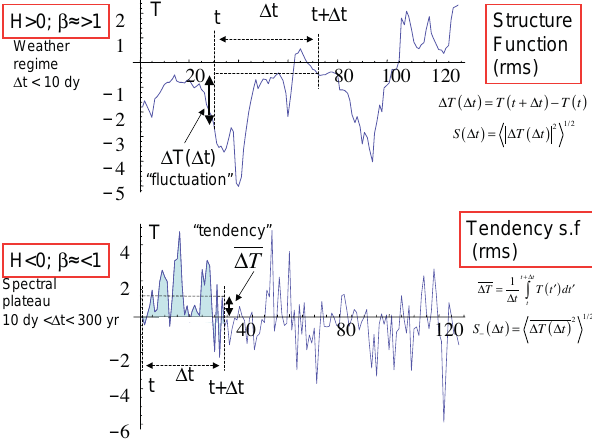
Fig. 2. The top shows extracts of a multifractal temperature simula- tion with H = 0.5, at one hour resolution (in the weather regime). The bottom is the same simulation but at 16-day resolution (in the low frequency weather regime, H = − 0.4). One can clearly see their differing characters corresponding to H > 0, H < 0 respec- tively (see also Fig. 1). These simulations are used to illustrate the two different types of structure function needed when H > 0 (the usual, difference) and H < 0, the “tendency” structure function. Whereas the usual structure function yields typical differences in T over an interval 1t , so that the mean is of no consequence, the tendency structure function uses the average of the field with the mean removed. In both cases, the q = 2 moment was chosen be- cause it is directly related to the spectrum. Taking the square root is useful since the result is then a direct measure of the “typical” fluctuations, e.g. for the T = the temperature, in units of